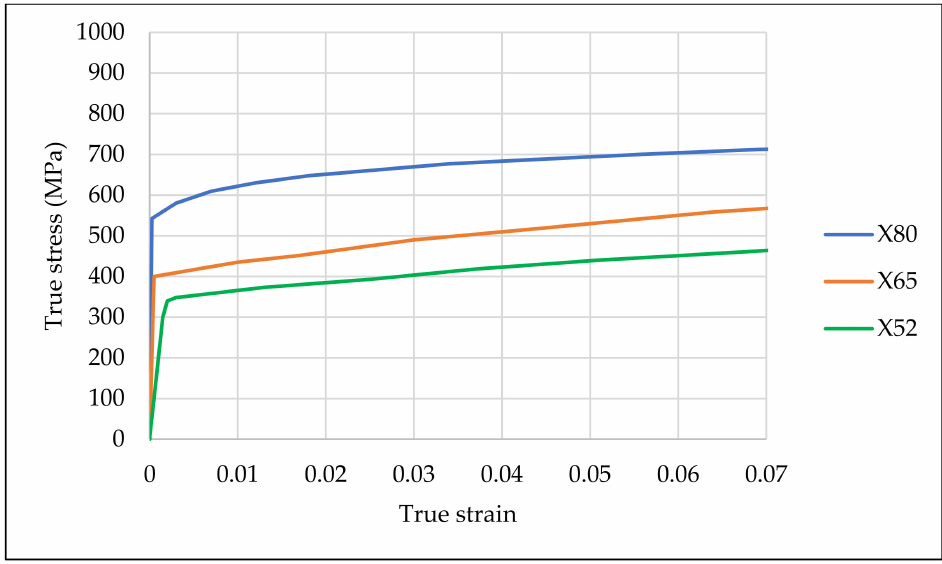
Figure 1. True stress–strain curve for API 5L X52, X65, and X80 steel pipe [5,7,20]. In this study, quarter pipes with rectangular shape idealization of corrosion defects were modeled using AutoCAD. Quarter models reduce computation time while rectangular defect idealization allows for a safer, lower bound failure pressure prediction without compromising on accuracy [4,5,7,10,21]. The pipes were modeled with end caps for even distribution of axial compressive stress and the full length of the model was set to 2000 mm to eliminate end cap influence [4,5,7,10]. Figure 2 illustrates an example of the quarter model used during the FEA.